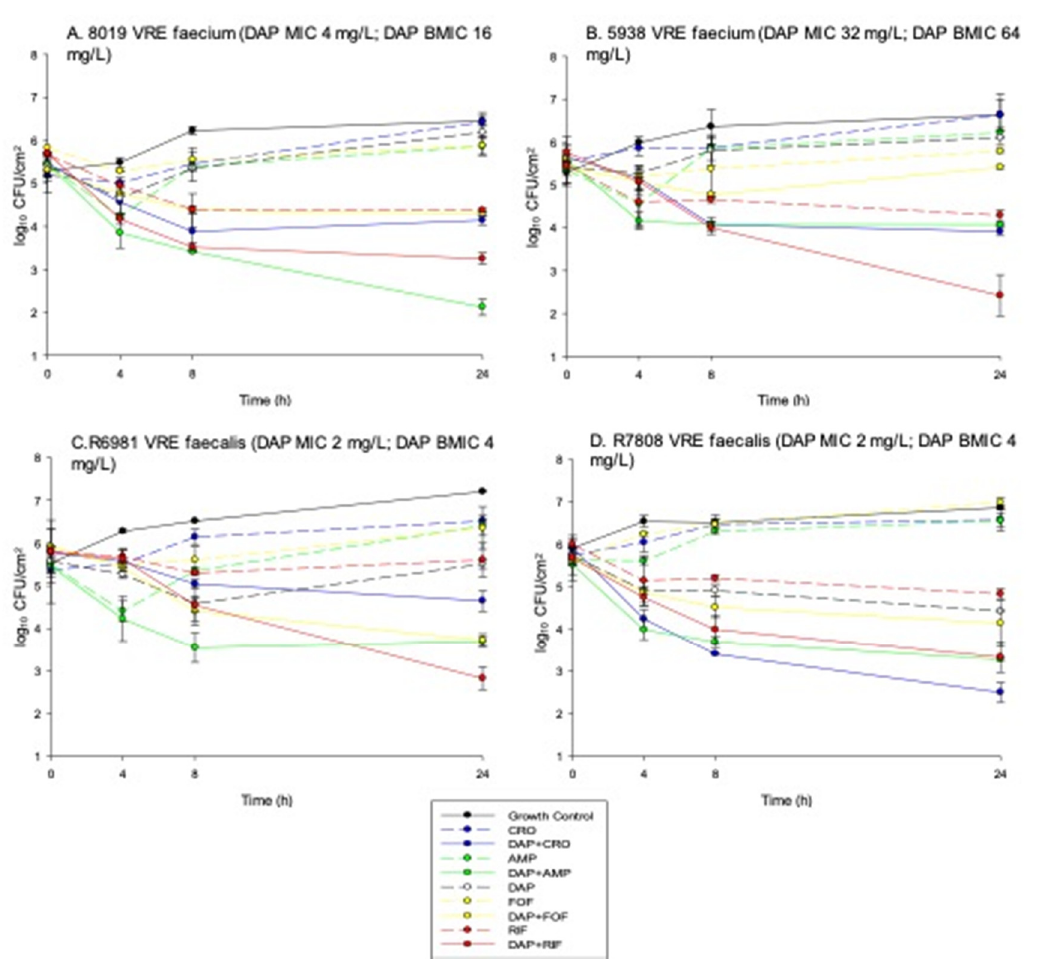
Figure 1. In vitro time kill curves: ( A ) E. faecium 8019, ( B ) E. faecium 5938, ( C ) E. faecalis 6981, ( D ) E. faecalis 7808 illustrating mean +/ − standard deviation of CFU/cm 2 . Table 1. Standard and Biofilm Minimum Inhibitory Concentrations (mg/L).